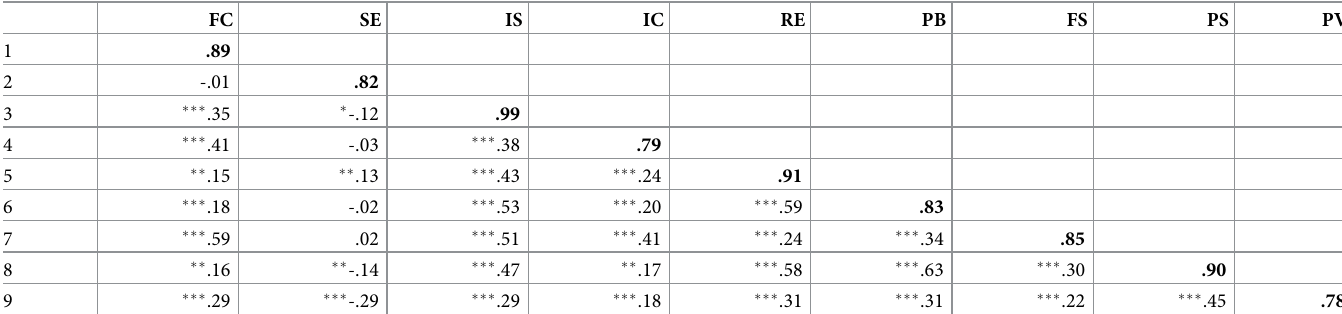
Table 3. Pearson correlation coefficient and Cronbach alpha (diagonally, bold) � — p < .05; �� — p < .01; ��� — p < .001.